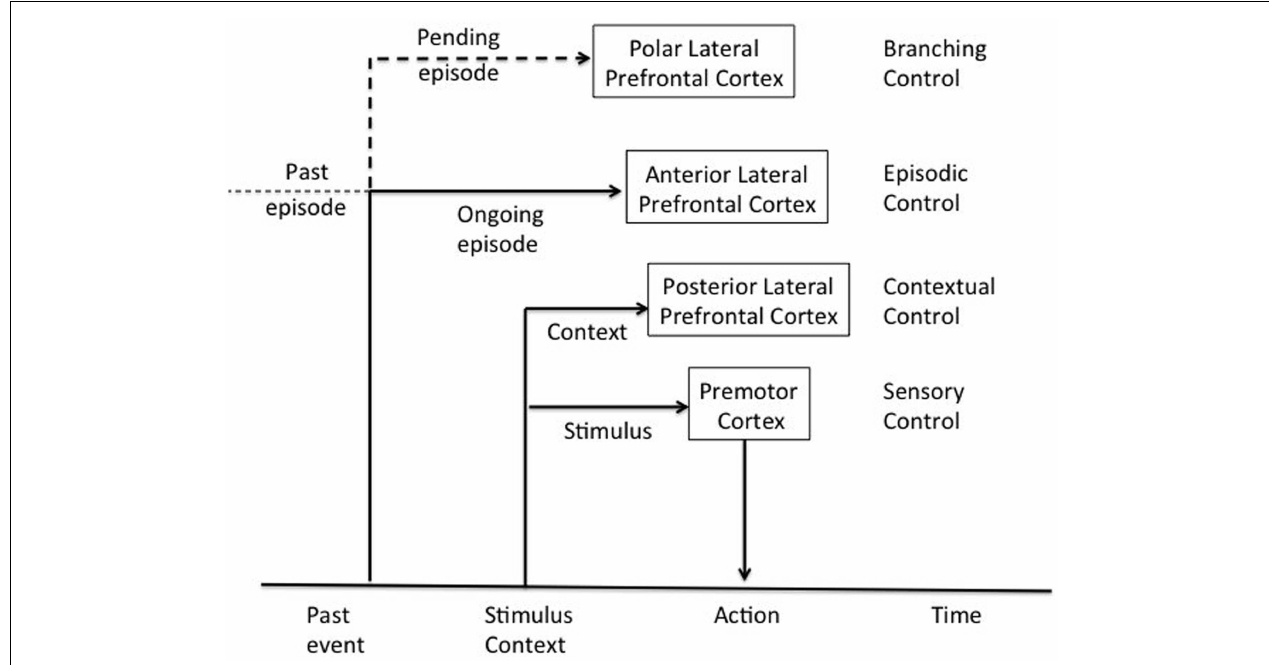
FIGURE 2 |Architecture of cognitive control of the human prefrontal cortex adapted from Koechlin et al. (2003) .